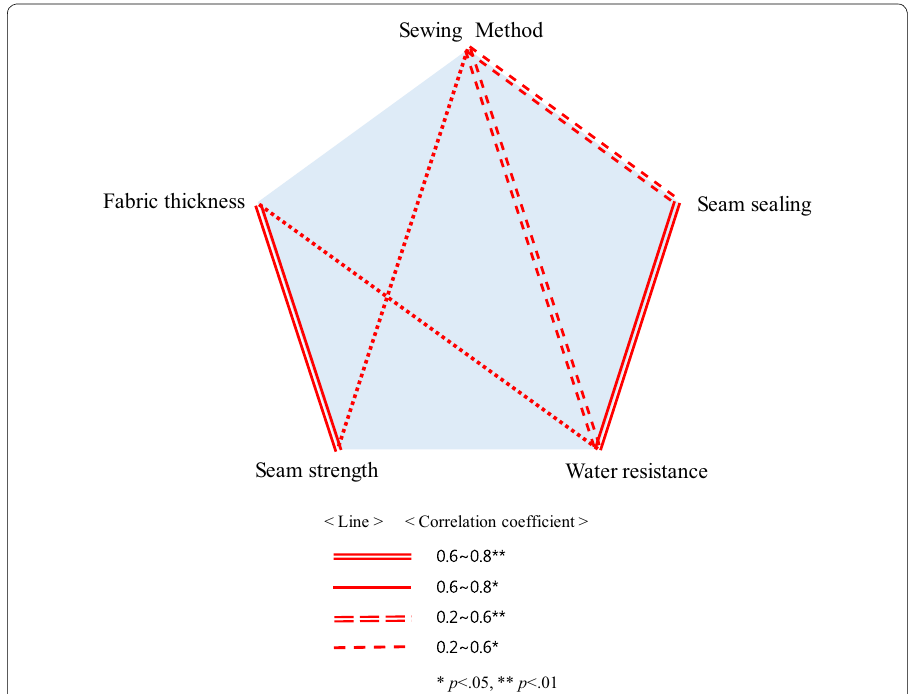
Fig. 3 Results of correlation coefficients among sewing method, seam strength, water resistance, fabric thickness, and seam